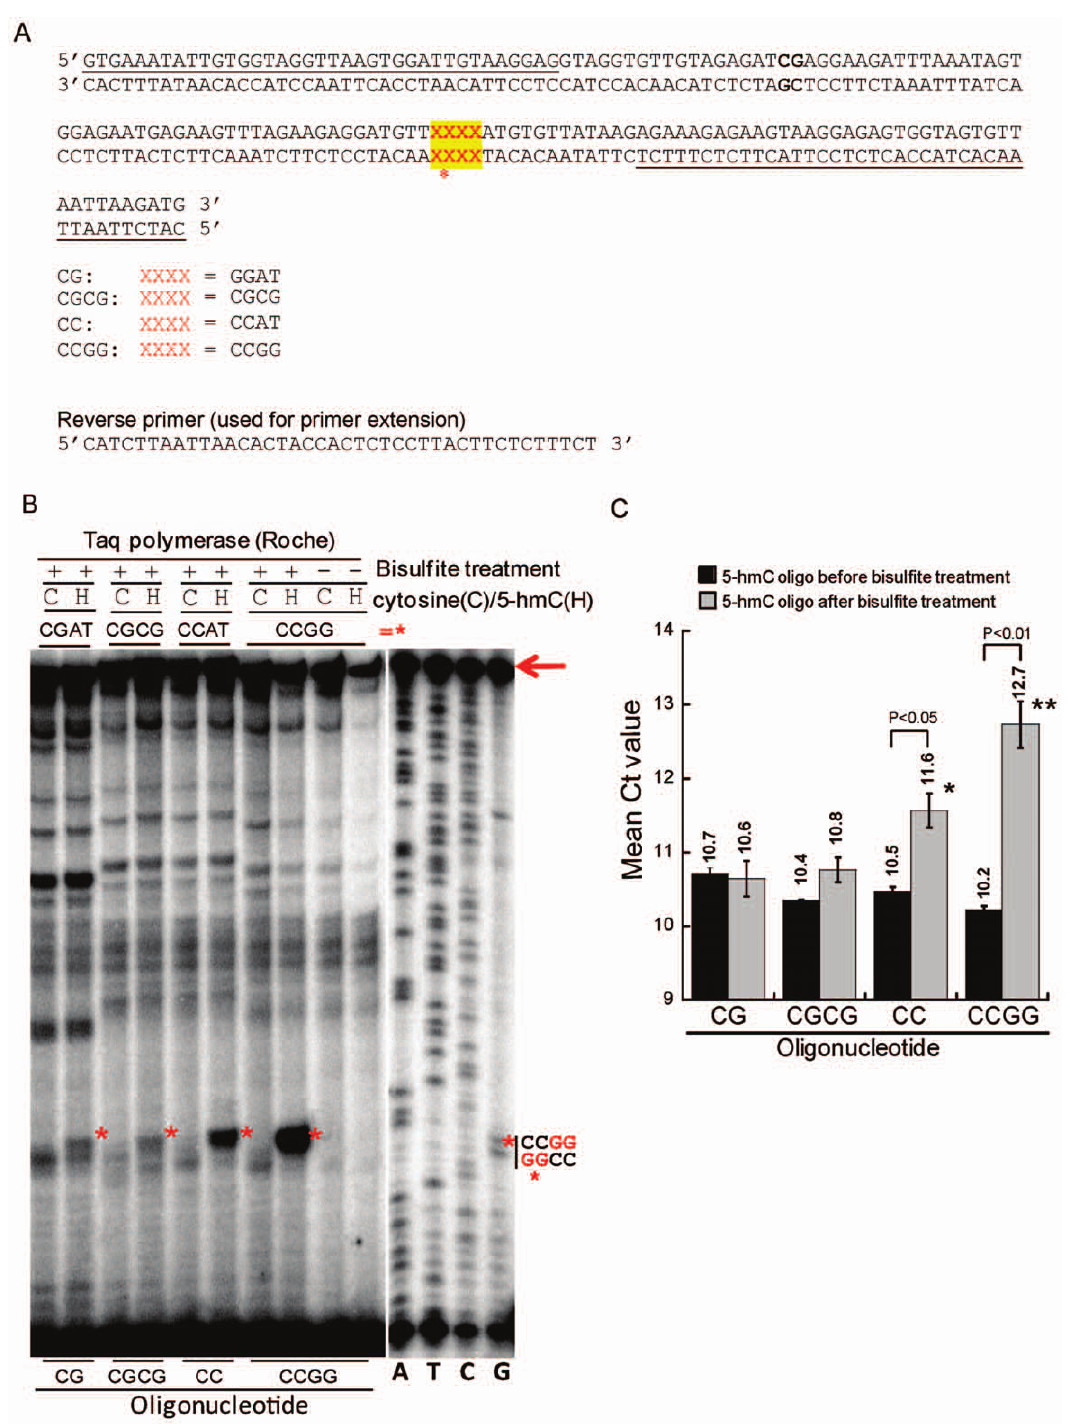
Figure 5. The bisulfite adduct of 5-hmC stalls Taq polymerase at CpG dinucleotides. (A) Sequences of a set of five 158 bp oligonucleotides used in this assay. At the position marked XXXX (red font with yellow highlight), the CG oligonucleotide contains the sequence CGAT, the CGCG oligonucleotide contains two tandem CGs, and the CC and CCGG oligonucleotides contain CCAT and CCGG sequences respectively. The underlined sequences correspond to the forward and reverse PCR primers used for PCR amplification. (B) Primer extension assays of oligonucleotides shown in Figure 5A . The bands corresponding to stalled PCR reactions (red asterisks, see XXXX in Figure 5A ) were most prominent in 5-hmC-containing CC and CCGG oligonucleotides after bisulfite treatment, and were observed, though less obvious, in the CG and CGCG oligonucleotides. Full length product is indicated by an arrow. Right lanes , the Sanger sequencing was performed using the CCGG oligonucleotide as a template. (C) Quantification of Ct value of real-time PCR from experiments performed on the substrates used in Figure 5A . The mean and standard deviation of three experiments is shown.